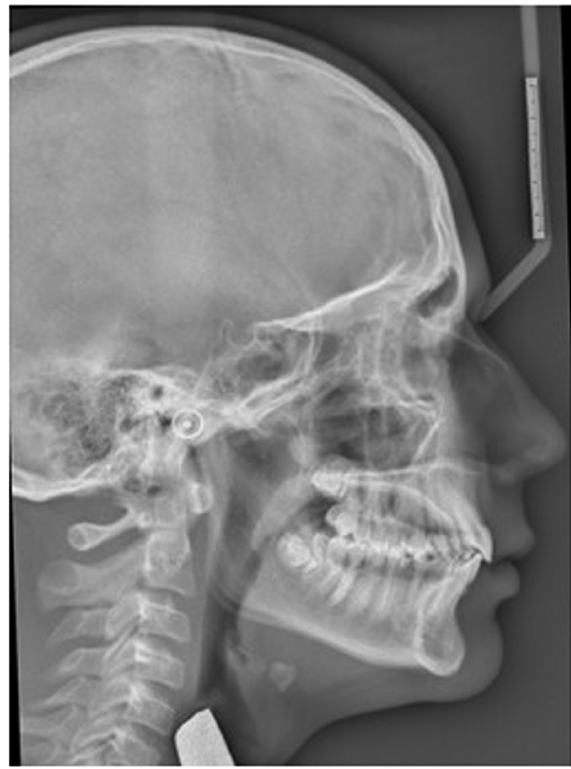
Figure 4. Pre-treatment lateral